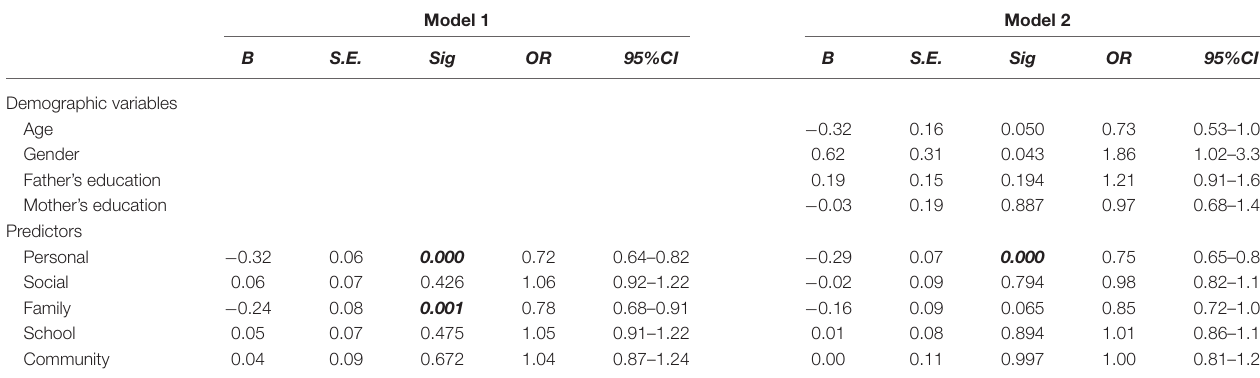
TABLE 5A | Associations between the five environmental asset categories and prolonged sadness: logistic regression analysis.